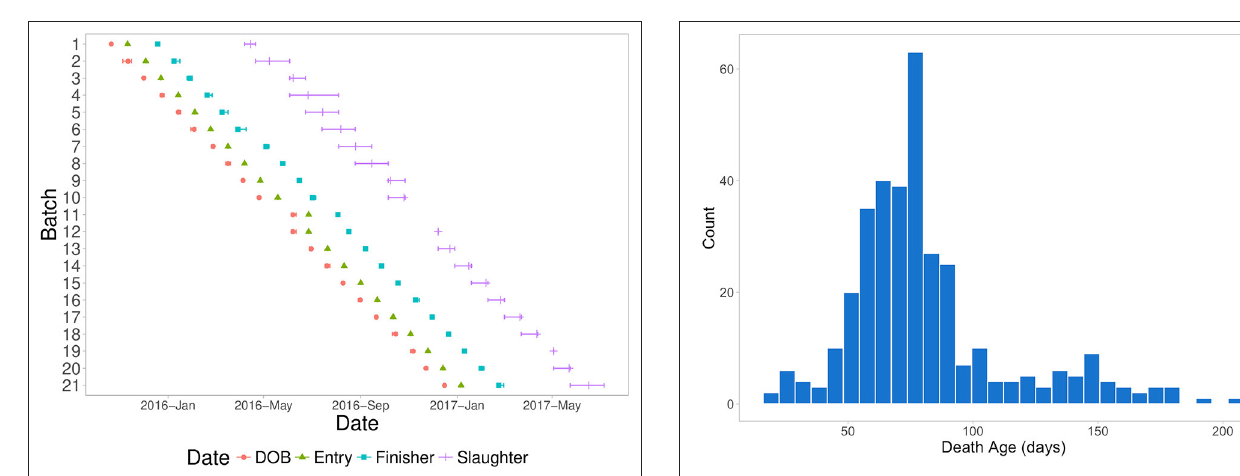
FIGURE 1 | Timeline of the batches entered into the natural challenge facility, including mean (symbol) and min/max (error bars) of each batch with date of birth (DOB), date of quarantine nursery entry (Entry), date of finisher entry (Finisher), and date of slaughter (Slaughter).